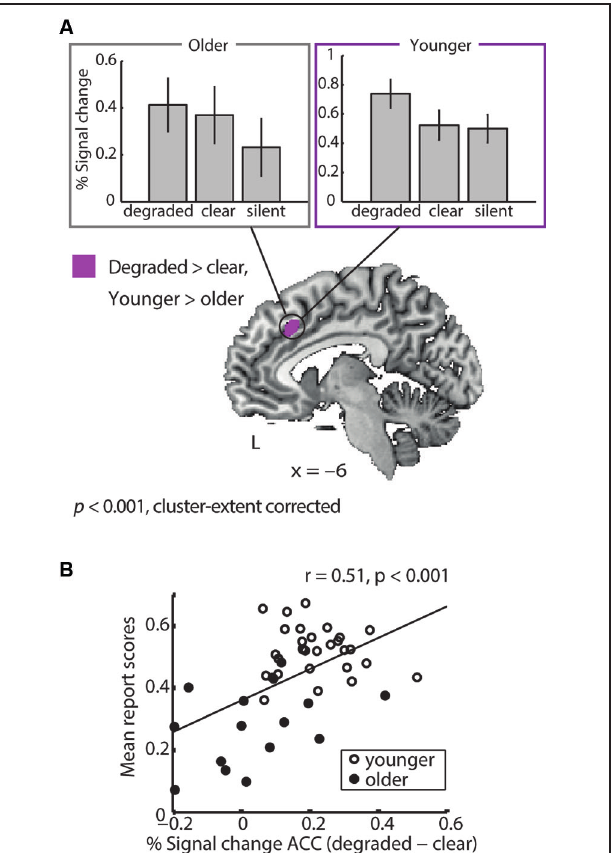
FIGURE 4 | (A) Age group × degradation interaction. Young adults showed a greater difference in anterior cingulate cortex (ACC) activity between degraded and clear speech than older adults. This age group × degradation interaction was driven by a reduced dynamic range in older adults, who displayed increased levels of ACC activation during perception of both clear and degraded speech. This is apparent in the bar graphs showing % signal change for both groups and conditions (upper panel). For comparison, signal change for silent trials is shown, illustrating that older but not younger adults upregulate ACC activity for clear compared to silent trials. (B) Correlation of ACC dynamics with performance. A post-hoc ROI analysis showed that across groups, individuals with a better overall degraded speech comprehension (mean report scores) showed a higher differentiation (degraded minus clear speech) in ACC